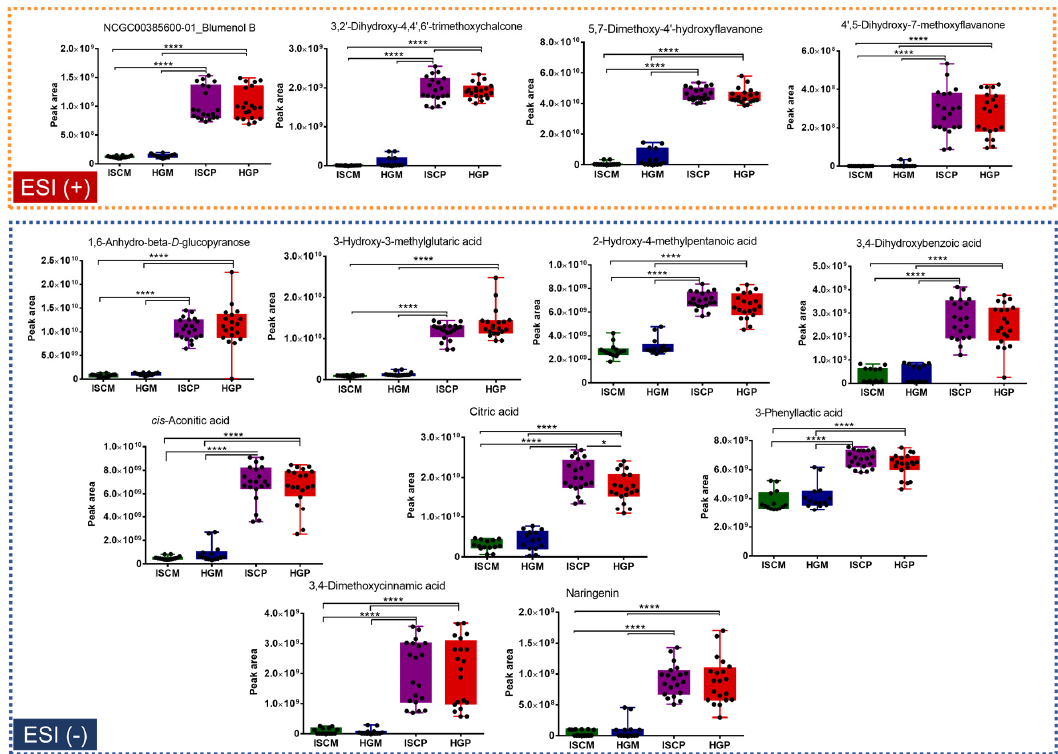
Figure 4. Box plot graphs of annotated metabolites responsible for the discrimination of P. sylvestris group from M. domestica in the PLS-DA model. Abbreviations: ISCM: M. domestica /APVAE, HGM: M. domestica /VAE, ISCP: P. sylvestris /APVAE; HGP: P. sylvestris /VAE. Tukey’s multiple comparison test was performed for significant difference. * p < 0.05; ** p < 0.01; *** p < 0.001; **** p < 0.0001. Molecules 2020 , 25 , x FOR PEER REVIEW